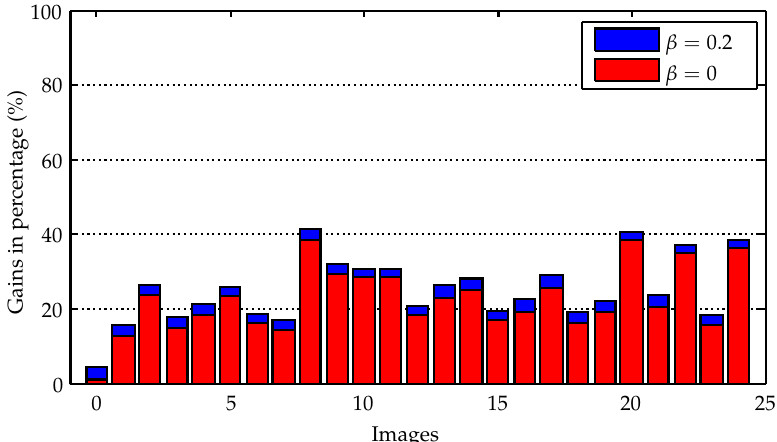
Figure 19. Percentage gains for the evaluated images. The best gains observed were for image 0, reaching around 4.3% for β = 0.2 and 1.1% for β = 0.2. As mentioned in Section 3, image 0 is a case of no changes in the dry- land region and two tiles containing possible vessels in the water region. That result can be considered compatible with scenarios of entirely images of water regions containing few